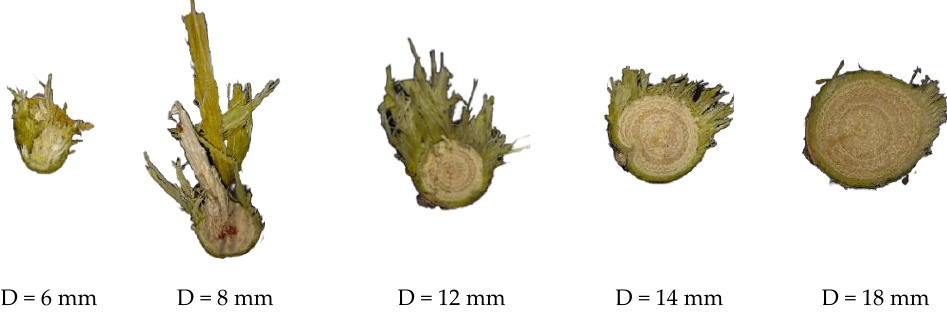
Figure 12. Schematic diagram of the forces on the branch sawing.